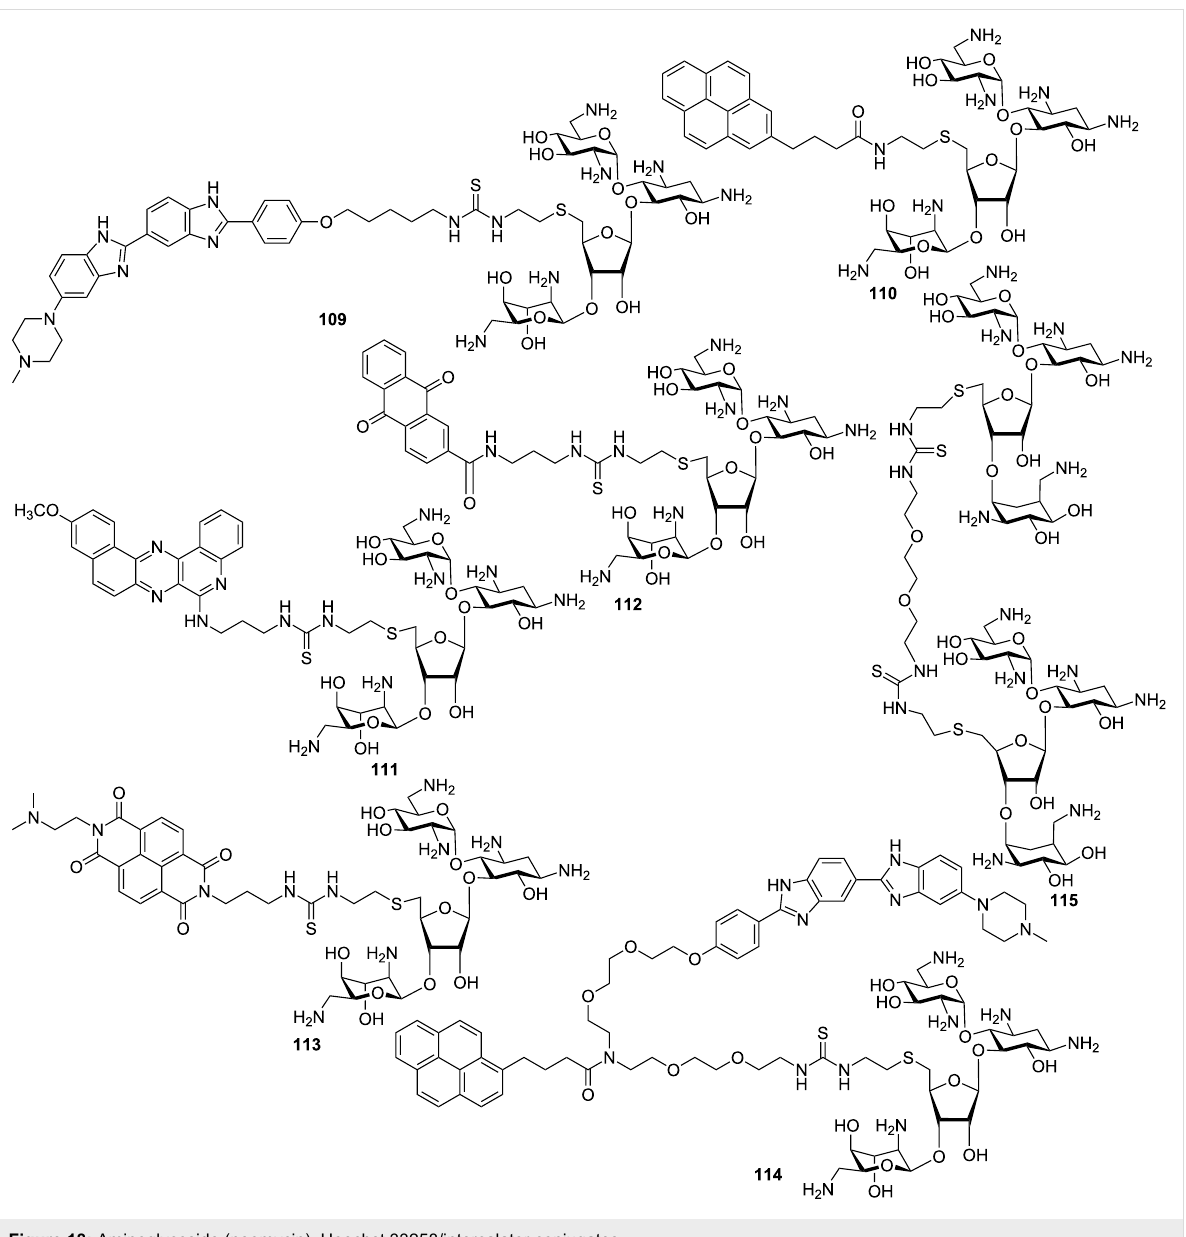
Figure 18: Aminoglycoside (neomycin)–Hoechst 33258/intercalator